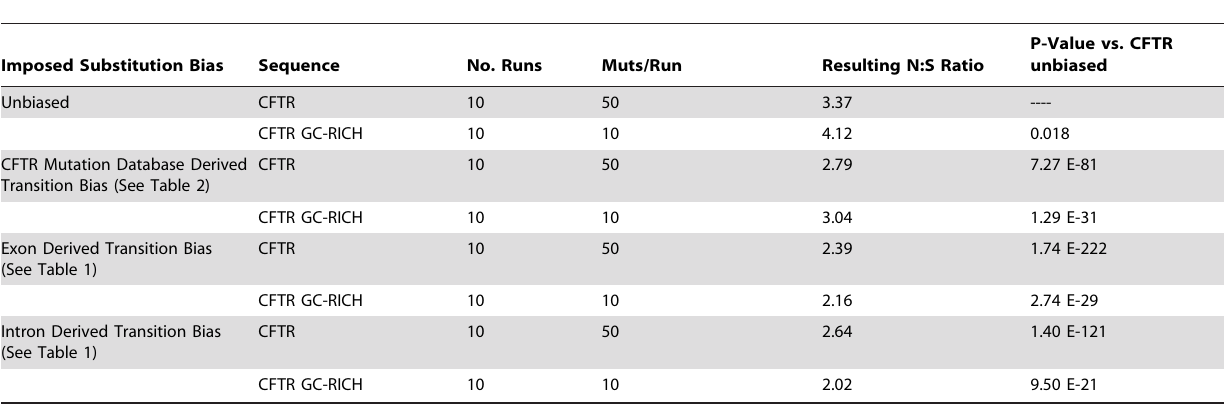
Table 4. Computer Simulation of SNP Accrual in the Setting of a Transition Bias Leads to Enhancement of Synonymous Variants.